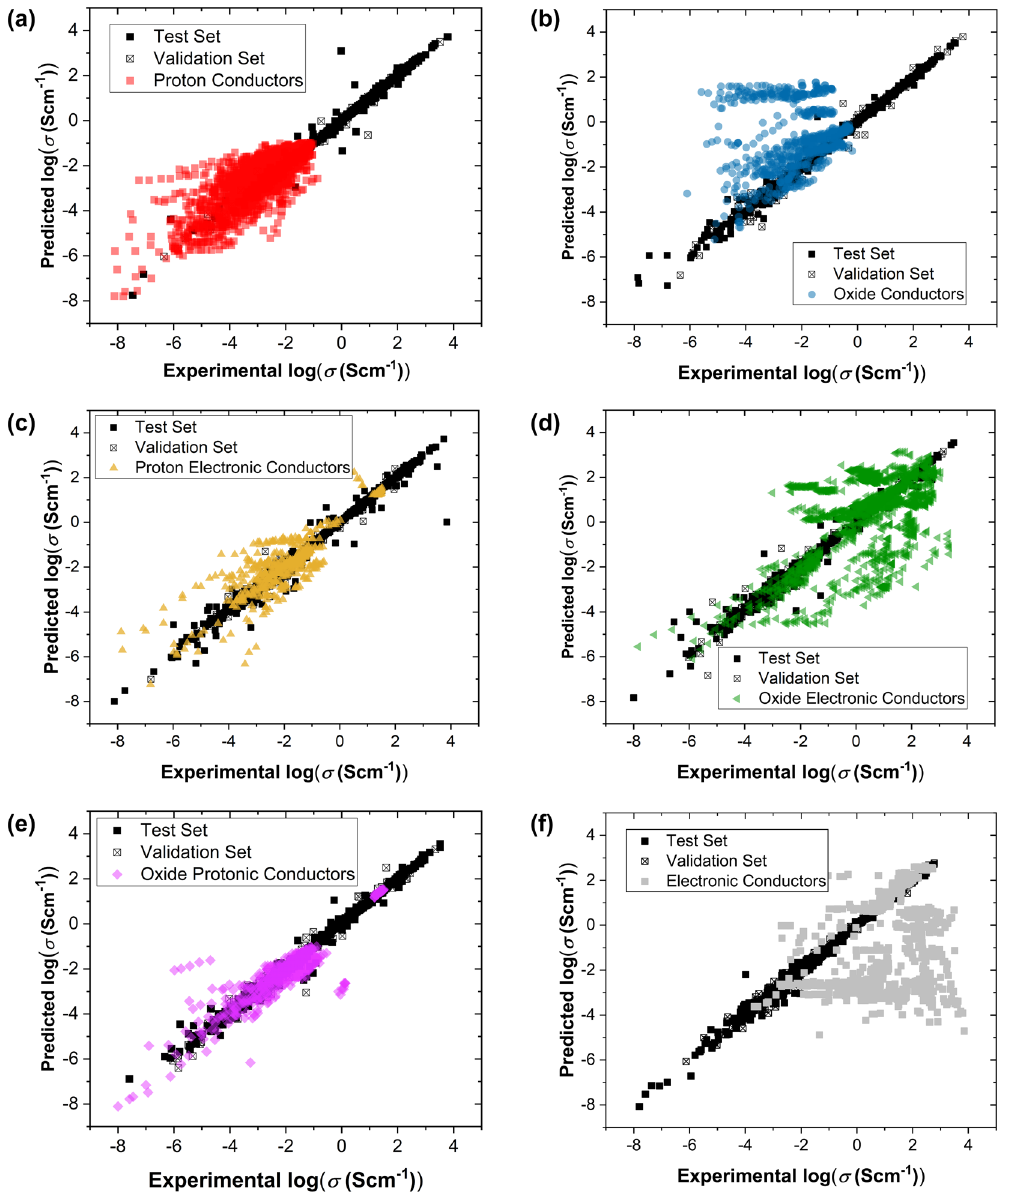
Fig. 7 The comparison of the predicted conductivities from the ML model with the experimental values for different set of data excluding a given class of material. Excluding a proton (H), b oxide (O), c protonic electronic (H + E), d oxide electronic (O + E), e oxide protonic (O + H), and f electronic (E) perovskite conductors. The performance of the model in predicting the excluded class is also